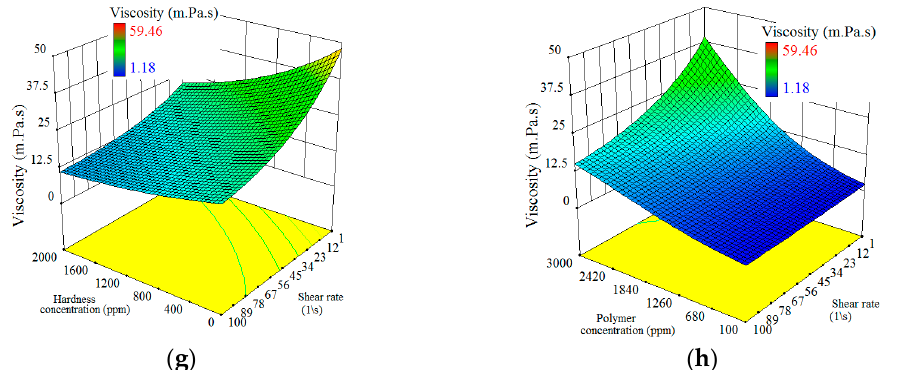
Figure 10. Model prediction as function of ( a ) polymer concentration and sulfonation degree, ( b ) salinity concentration and molecular weight, ( c ) polymer concentration and molecular weight, ( d ) shear rate and molecular weight, ( e ) salinity concentration and hardness concentration, ( f ) polymer concentration and salinity concentration, ( g ) shear rate and hardness concentration, ( h ) shear rate and polymer concentration.